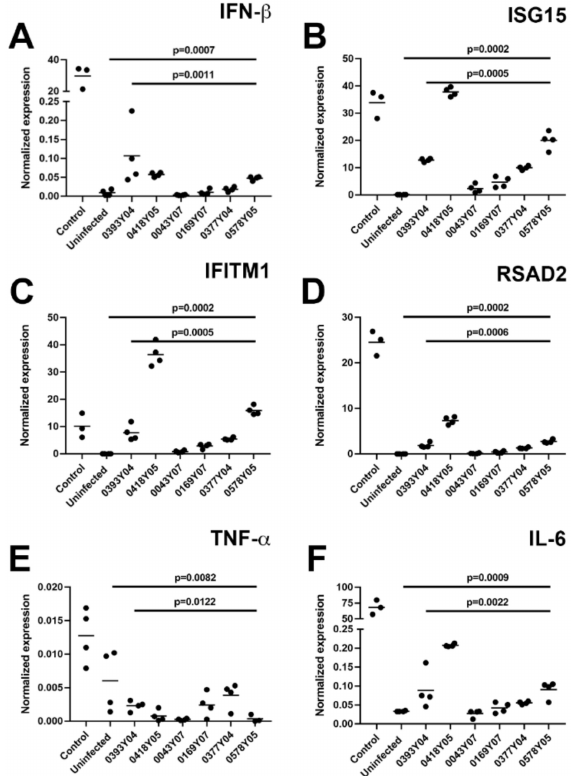
Figure 2. Molecular response of human retinal pigment epithelial cells to infection with DENV- 1 and DENV-2 strains: DENV-1 viral strains = Singapore National Environmental Agency Isolate (EHI)0393Y04, EHI0418Y05 (from 2005 epidemic), EHI0043Y07 and EHI0169Y07 (from 2007 epidemic); DENV-2 viral strains = EHI0377Y04 and EHI0578Y05 (from during 2005 epidemic); ARPE-19 human retinal pigment epithelial cell line; multiplicity of infection = 10; inoculation interval = 90 min; time of infection = 48 h. ( A – F ) Graphs showing cellular expression of transcript relative to TATA box-binding protein (TBP): IFN- β = interferon- β , IFITM1 = IFN-induced transmembrane protein 1, RSAD2 = radical SAM domain-containing 2, ISG15 = IFN-stimulated gene 15, TNF- α = tumor necrosis factor- α , IL-6 = interleukin-6. Dots represent individual cell monolayers ( n = 3–4 monolayers per condition), and crossbars represent means. Control was the laboratory-adapted Mon601 strain. Data were analyzed by Kruskal–Wallis